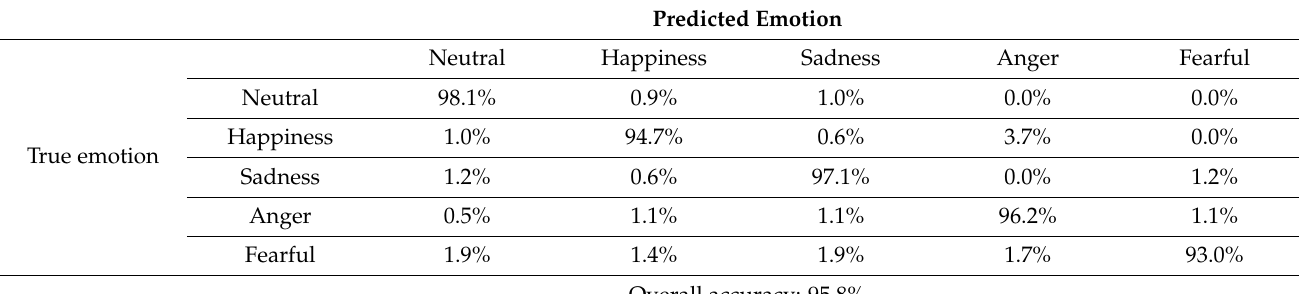
Table 9. Confusion matrix of the emotion classification results of the proposed cascaded DnCNN–CNN that was trained on the original Korean